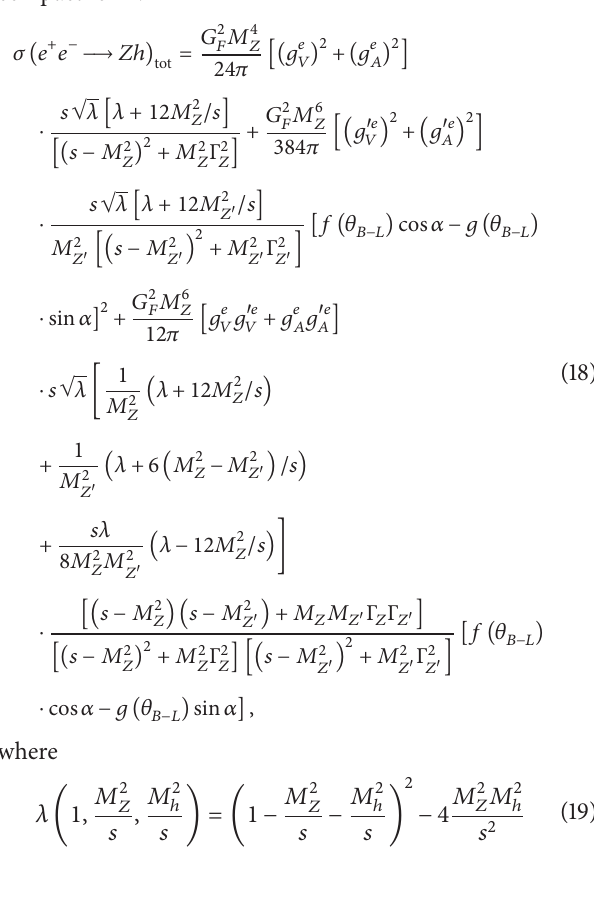
󸀠𝑓 𝑔 󸀠𝑓 𝑍 󸀠 boson with 𝑉 and 𝐴 of the